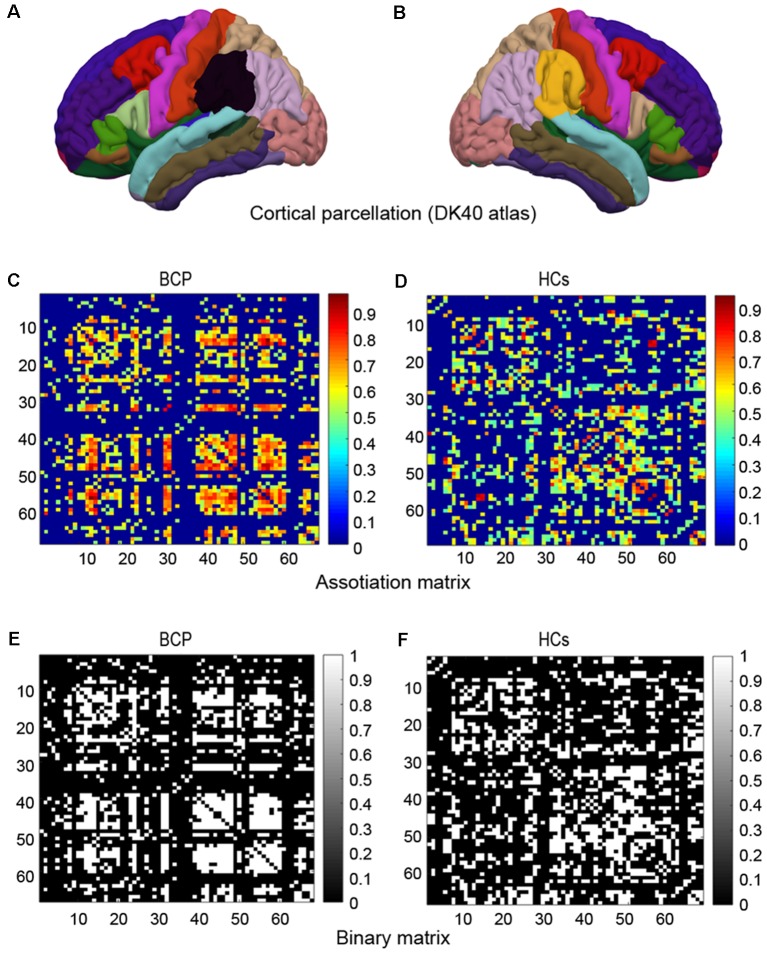
Cortical parcellation, association matrix and binary matrix. Cortical parcellation is according to DK40 atlas (A,B). Correlation matrices for the bilateral cerebral palsy (BCP; C) and healthy controls (HCs; D). The color-bar shows the strength of the connections. Binary adjacency matrices for the BCP (E) and the HCs (F), with white indicating the presence of connection and black the absence of one.